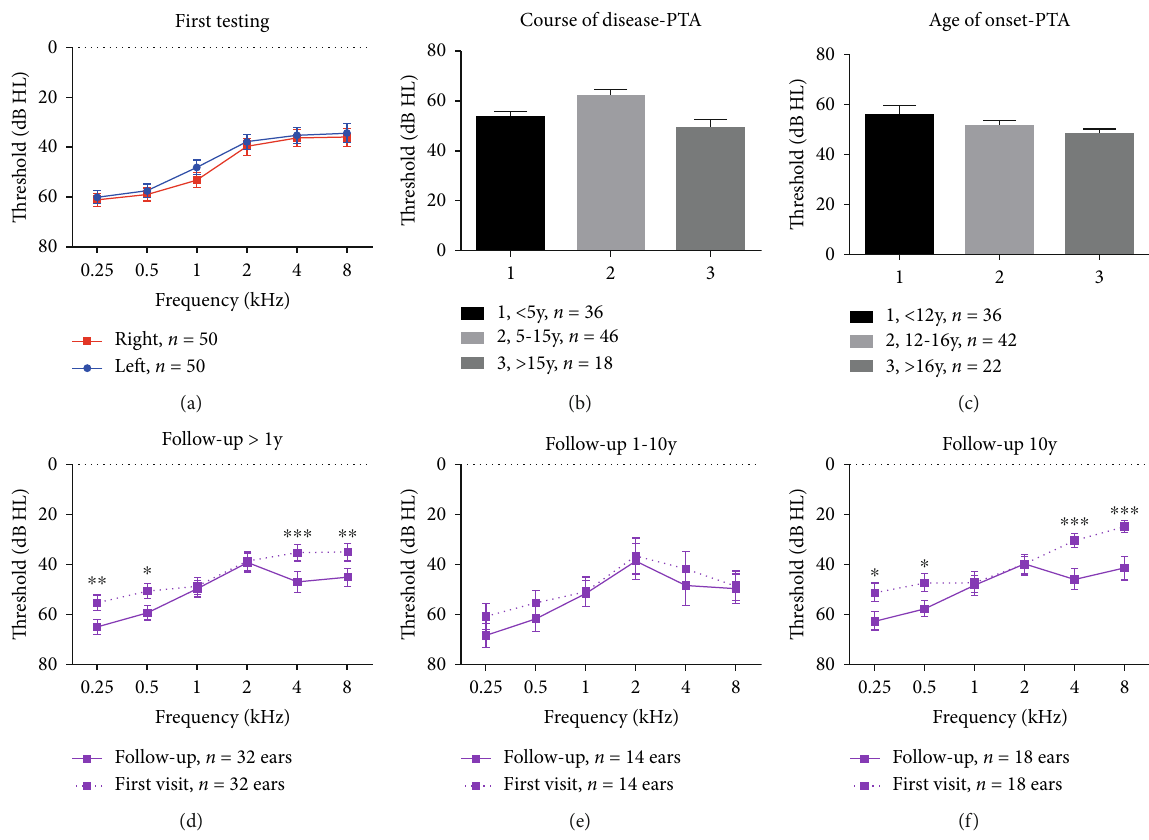
Figure 1: Pure tone test of the AIFM1 -positive cases. (a) Average threshold of the 50 cases with AIFM1 variations. (b) Mean PTA in the groups with di ff erent disease courses. (c) Mean PTA in the groups with di ff erent onset ages. (d-f) Mean threshold in each frequency with di ff erent follow-up periods. dB: decibels; Hz: Hertz; PTA: pure tone